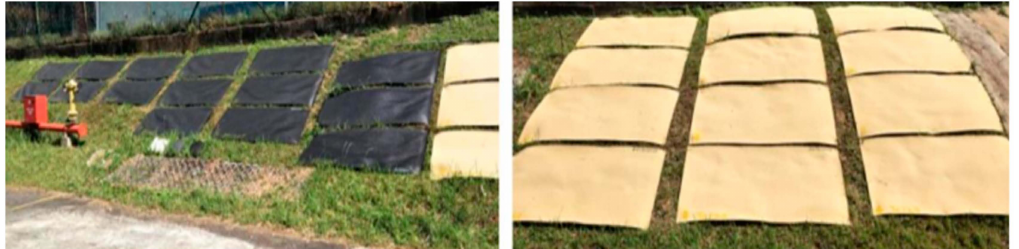
Figure 2. Outdoor UV weathering test for woven (black) and composite (yellow) (Courtesy: Tencate Geosynthetics